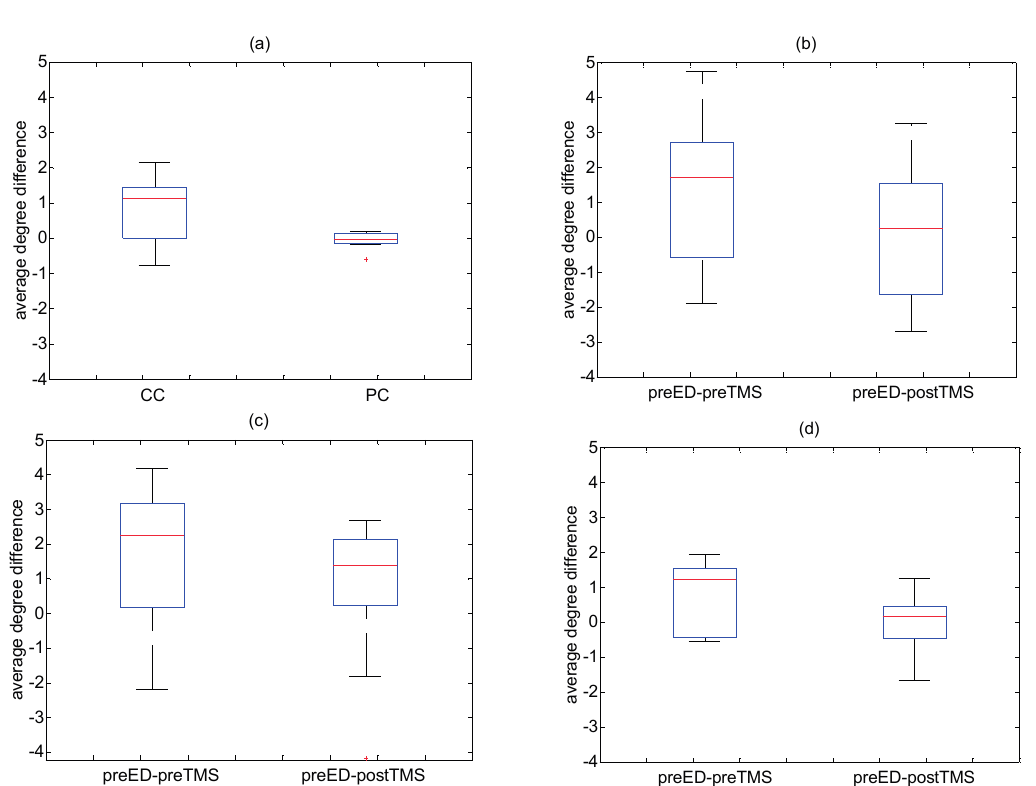
Figure 5. ( a ) Boxplots for the average degree differences of preED-ED for the method FDR-R using (denoted CC) and (denoted PC); ( b ) Boxplots for the